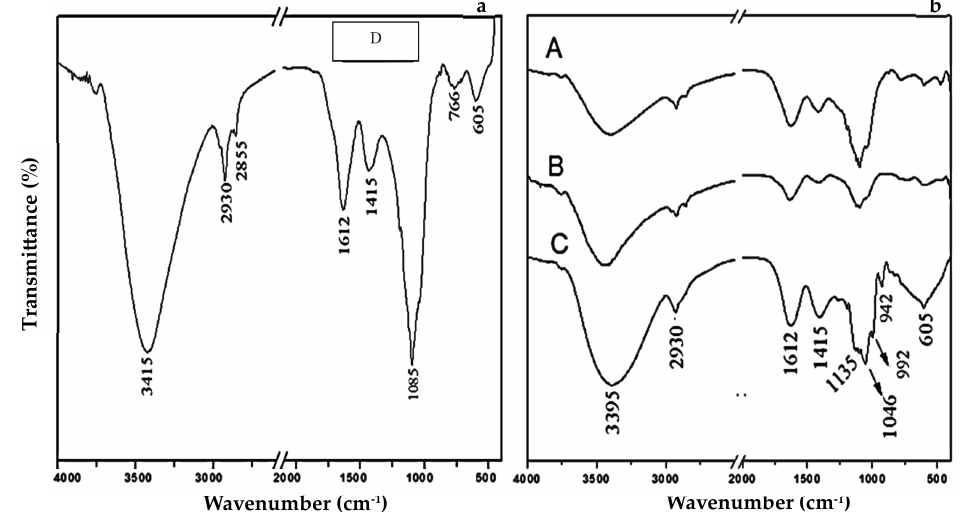
Figure 2. Infrared spectrum of polysaccharides, recorded for wavelengths 500–4000 cm − 1 . D refers to the polysaccharides detected in not fermented beverage ( a ). A, B, and C refer to the polysaccharides detected in the beverages fermented with the selected cultures FB-sp, FB-lcsp, and FB-lc, respectively ( b